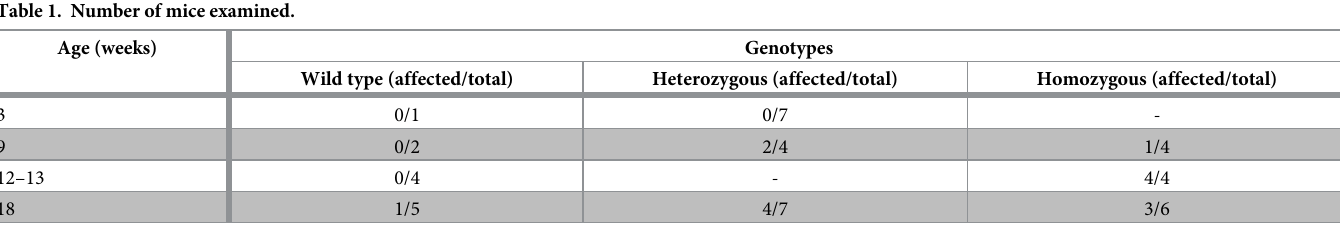
The affected mice included those mice showing unilateral and bilateral hearing